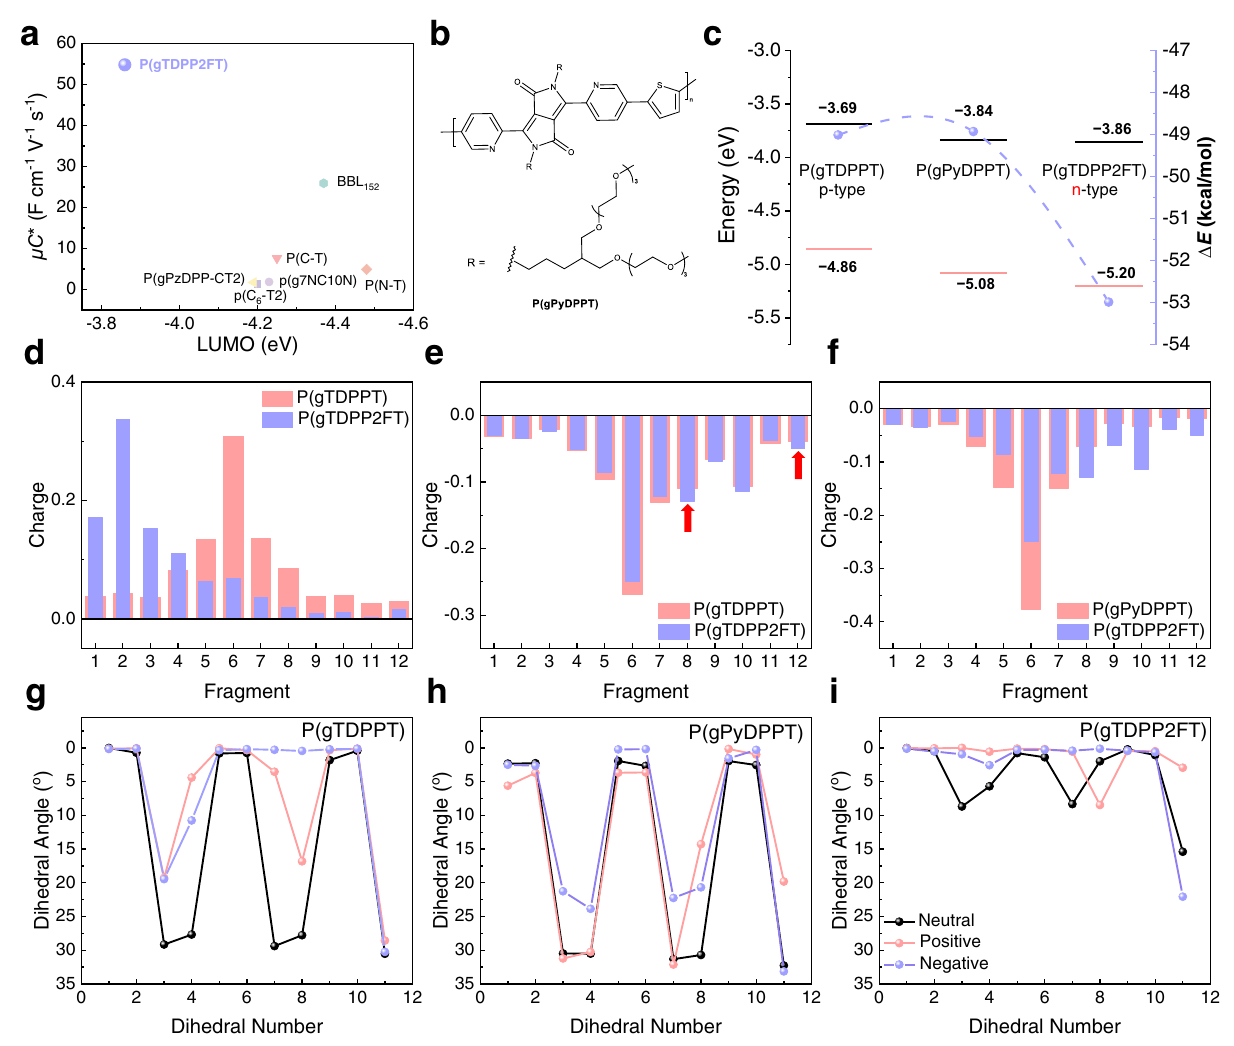
Fig. 5 | Understanding of the “ doped state engineering ” . a Comparison of the LUMOenergylevelsmeasuredbyCVand μ C* ofP(gTDPP2FT)andseveralreported n-type OECTs materials 25,27 – 30,38,45 . b Chemical structure of the reference polymer, P(gPyDPPT). c Comparison ofthe HOMO/LUMOenergy levelsmeasured bythe CV and the energy difference between neutral and negatively charged states ( Δ E = E negative − E neutral ).BlacklinesstandforLUMO,andredlinesstandforHOMOenergy level.Purpledotsstandfor Δ E values. d – f Comparisonofthechargedistributionsof the positively/negatively charged trimers of the three polymers. Comparison of